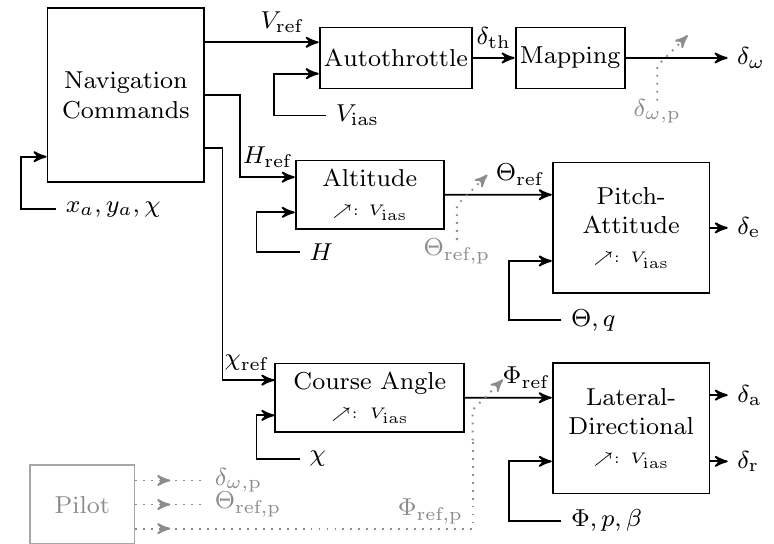
Figure 4. Control architecture for fully automated flight (mode (iii)), and augmented flight (mode (ii)), indicated in gray.